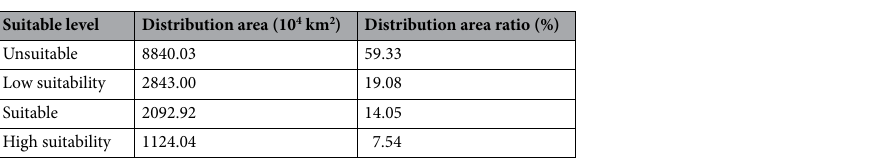
Table 2. Area and proportion of different suitability levels for global Sapindus habitats under the current environment.